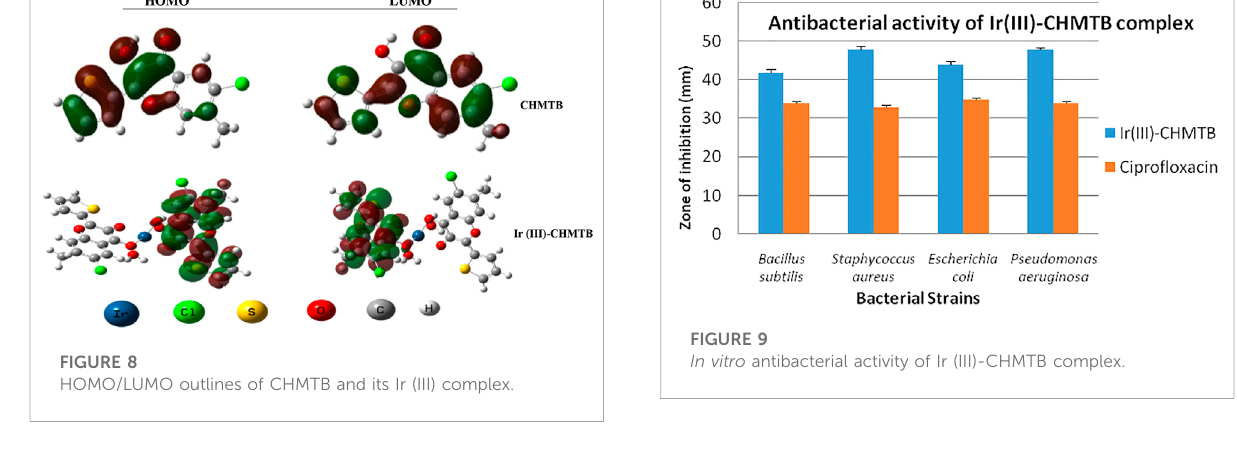
TABLE 7 Investigation of miscellaneous mixtures and alloys by the suggested